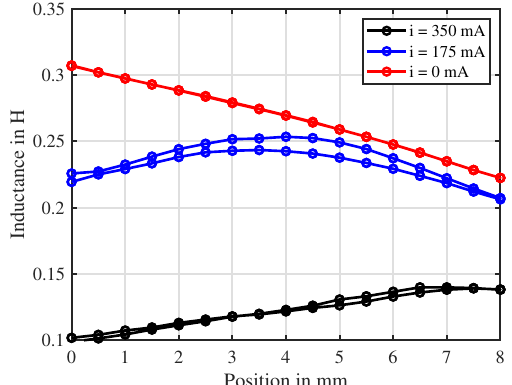
Figure 16. Identified inductance variation over changing position at three different fixed currents. The dependency is slightly hysteretic, in particular for middle range